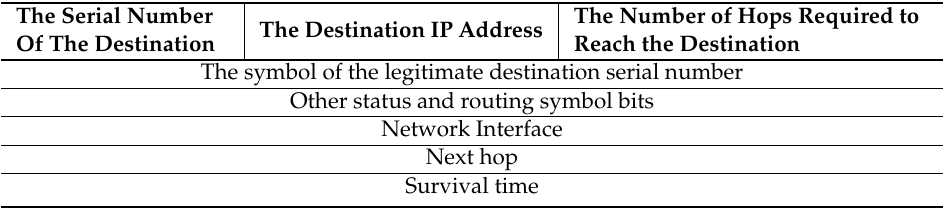
Table 1. Routing Table